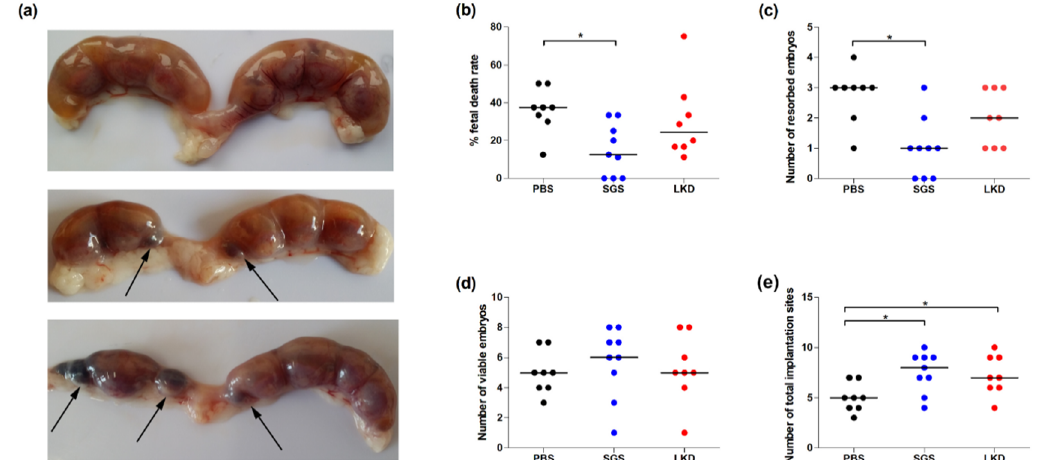
Figure 1. ( a ) Representative pictures of the uteri showing resorbing (arrows) and viable implantation sites and the effect of SGS and LKD peptides on the ( b ) fetal death rate, ( c ) number of resorbed embryos, ( d ) number of viable embryos, and ( e ) total implantation sites at 14 dpc in abortion-prone mice. The data were analyzed using one-way analysis of variance (normally distributed data), followed by Bonferroni’s multiple comparison post hoc test or Kruskal–Wallis test (non-normal distributed data), followed by Dunn’s multiple comparison post hoc test ( p < 0.05). Data are presented as individual values with the median. * p < 0.05.